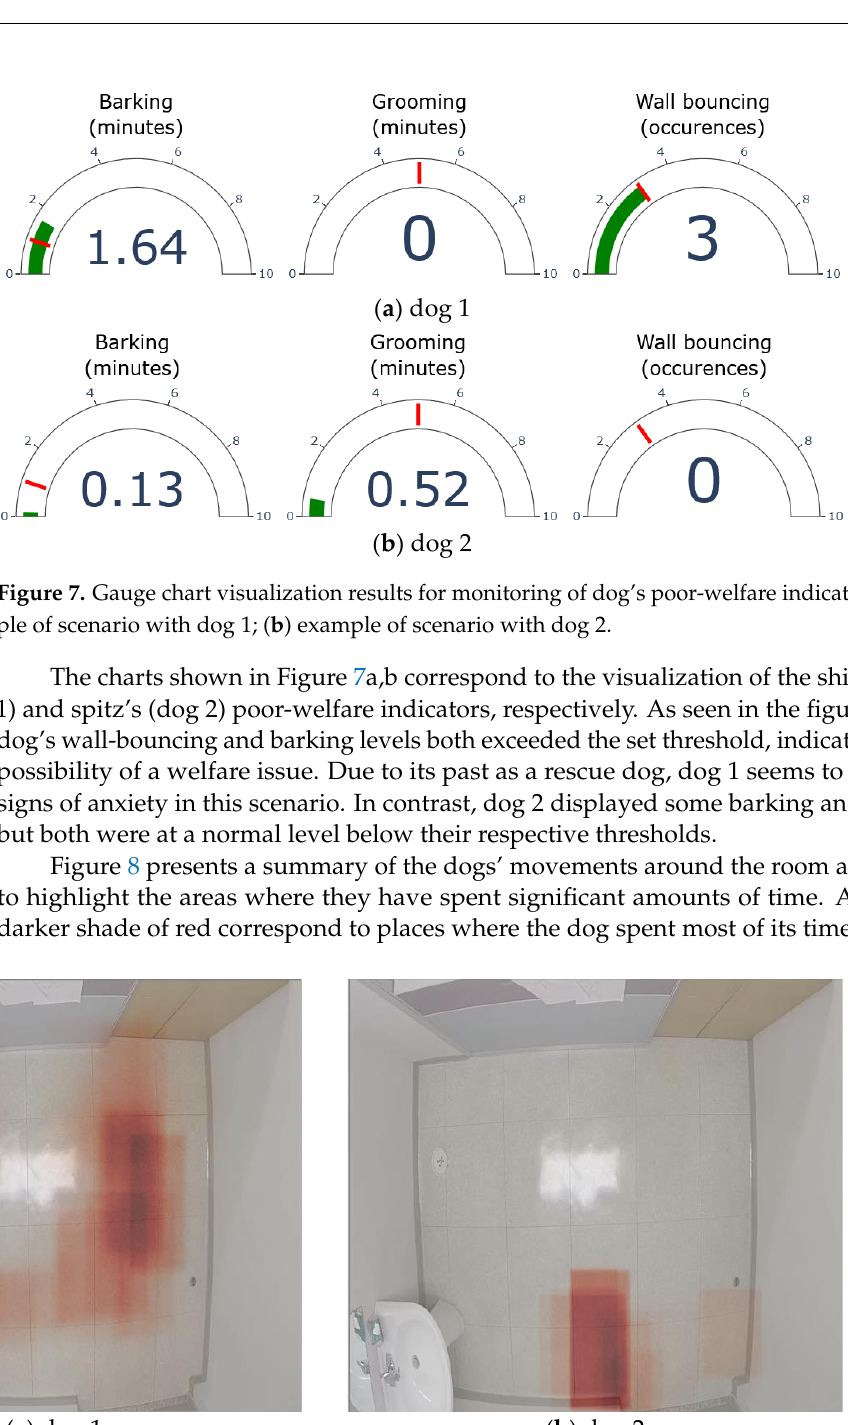
( b ) dog 2 Figure 9. Trajectory visualization tool for displaying dog’s movement patterns: ( a ) example of sce- nario with dog 1; ( b ) example of scenario with dog 2. The scenarios shown in Figure 9 represent the same ones used in Figure 8 to detail both dogs’ movement trajectories starting from the blue circle and following the color map shown in the legend and ending in the red circle. As seen in Figure 9a, dog 1 shows signs of restlessness, pacing, and a few occurrences of circling, all of which indicate a level of anxiety and possible welfare issues. In contrast, dog 2 in Figure 9b shows a simpler trajec- tory with a lack of exploration and activity, which suggests a relaxed state. Another visualization provided by the system is the proportion of detected dog be- haviors based on logged data using a doughnut chart. The chart shows the proportion of active and static behaviors as a general category and includes a nested level detailing the